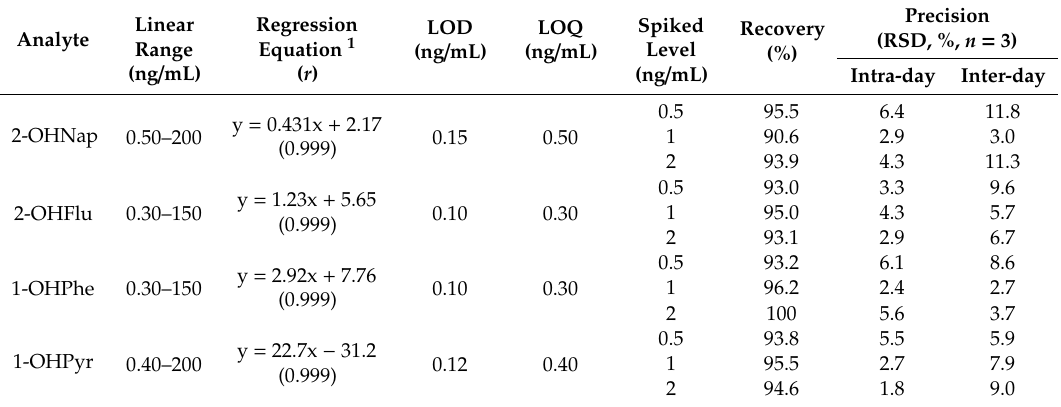
Table 2. Linear Range, Limits of Detection (LODs), Limits of Quantification (LOQ), Recovery, and Precision of the Developed